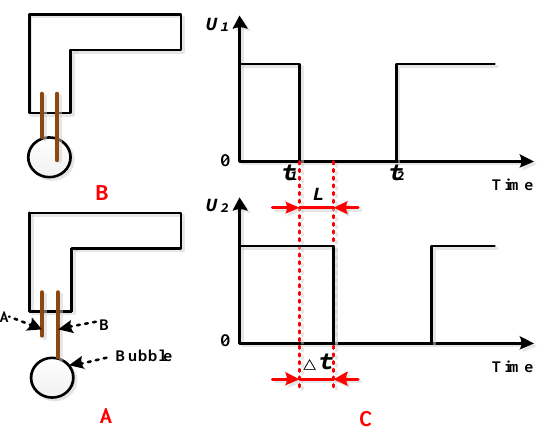
Figure 5. The principle of bubble velocity detection. ( A ) The rising bubble first hit Electrode B; ( B ) the same bubble then hit Electrode A; ( C ) the output signals of this progress.